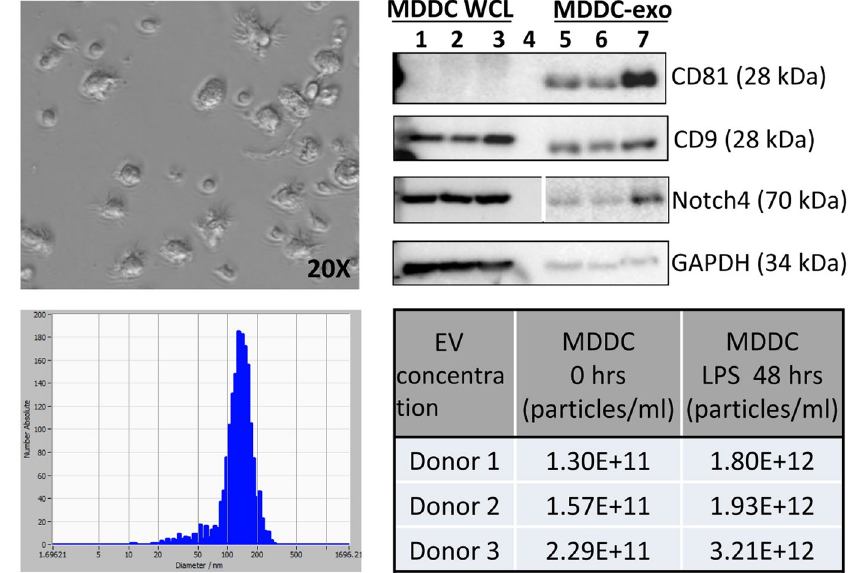
Figure 6. Exosomes released from cultured MDDCs carry Notch4 protein. MDDCs (from n = 3 healthy donors) cultured for 5 days with exosome-depleted FBS were treated with LPS (100 ng/ml) for additional 48 hrs to induce maturation (top left panel). Exosomes were isolated from culture supernatants of mature MDDC; EV concentration and size distribution was measured before and after (48 hrs) LPS treatment, by nanoparticle tracking analysis (bottom panel). Protein extracted from mature MDDC whole cell lysates and exosomes (30 μ g/lane) was immunoblotted for exosome markers, Notch4, and GAPDH (top right). Lanes 1–3 = whole cell lysates, lane 4 = PBS blank, lane 5–7 = mature MDDC derived exosomes. Blots are cropped and full-length blots are included in Supplementary Figure